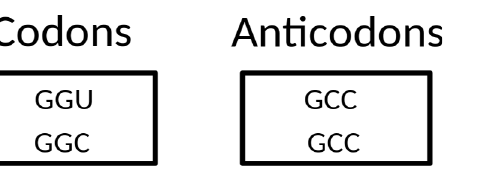
Fig 2. Start of the genetic code with a single tRNA encoding a single amino acid (tentatively selected as Gly). In the left hand panel the codons are indicated which are in efficient and unambiguous use. In the right hand panel the anticodons are indicated which perform the efficient and unambiguous decoding of these codons. The same division between left hand panel and right hand panel is used in Figs 3 –